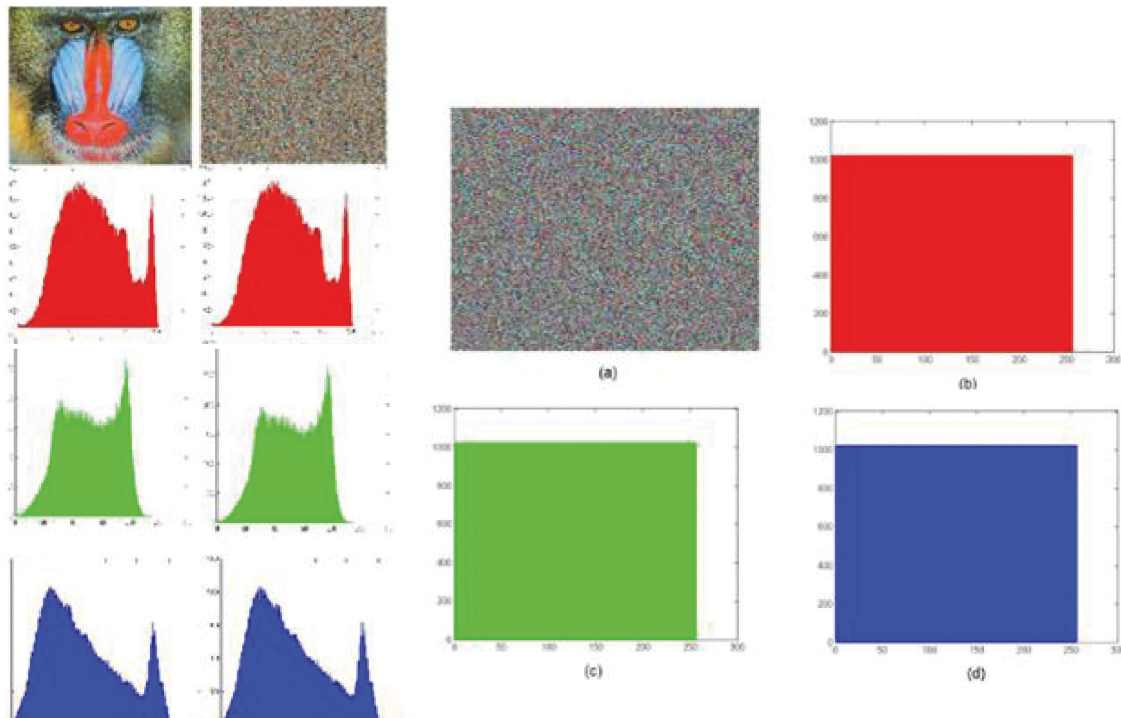
Figure 11: Histogram of baboon image with their histogram after and before